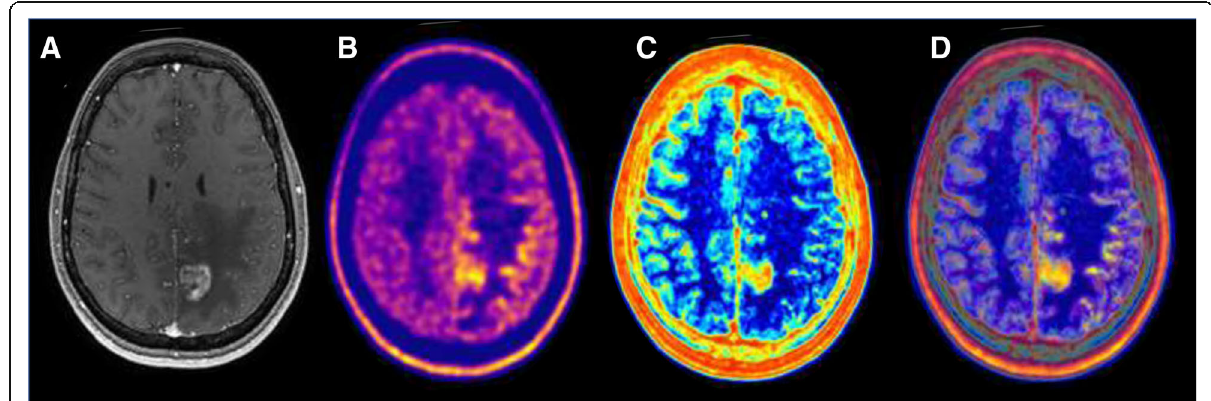
Fig. 4 Multimodal image-guided management using artificial intelligence in glioblastoma. This case illustrates the potential interest of imaging biomarkers extracted using artificial intelligence. Imaging of a patient with glioblastoma. a Baseline T1 post-contrast MRI prior to therapy demonstrating an enhancing lesion. b Baseline 18F-Dopa PET showing an increased amino acid uptake outside of the enhancing lesion on MRI. c Analysis of the MRI by artificial intelligence demonstrating areas with high heterogeneity (red) and low heterogeneity in normal healthy brain tissue (blue). This map is a parametric map of local entropy computed using the baseline T1 post-contrast MRI. The only limit in the analysis of the local heterogeneity/entropy is that contours/edge/interface are always heterogeneous. d Fused image of the Baseline 18F-Dopa PET ( b ) and of the parametric map of local entropy ( c